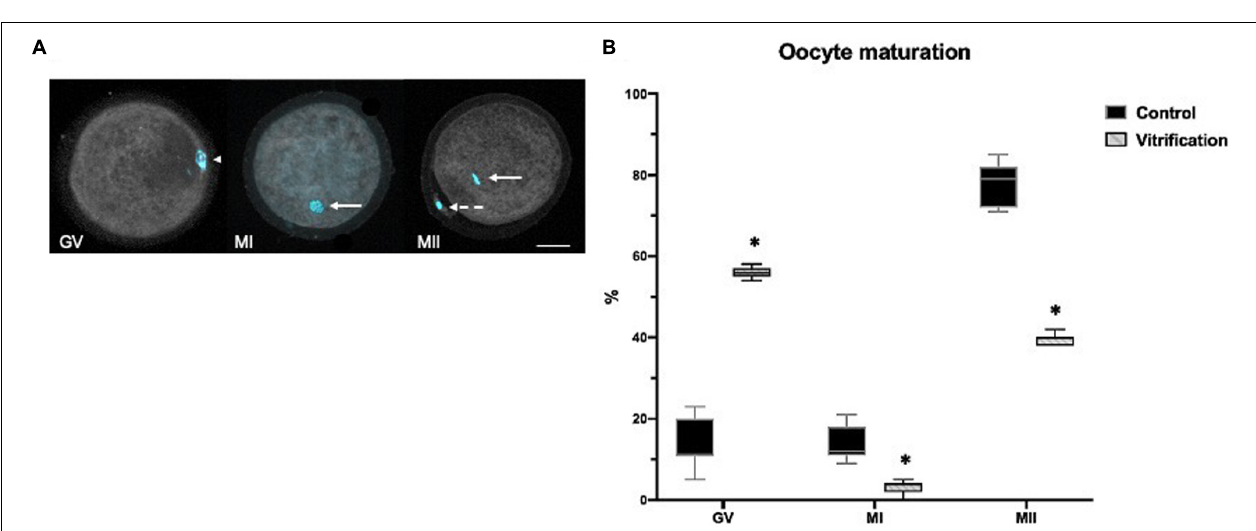
FIGURE 1 | Oocyte and embryo viability evaluation by methyl tetrazolium (MTT) staining in control and vitrified groups: (A) representative image for oocyte viability evaluation criteria (continuous arrows show purple living cells, and dotted arrows show colorless dead cells); 10 × , scale bar = 50 µ m; (B) percentage of oocyte viability at T 0 h, after T 44 h-IVM and early embryos after T 40 and 68 h-ED; the total numbers of evaluated cells in the control and vitrification groups were 386 and 381, respectively. *Significant difference vs. control. P < 0.05.